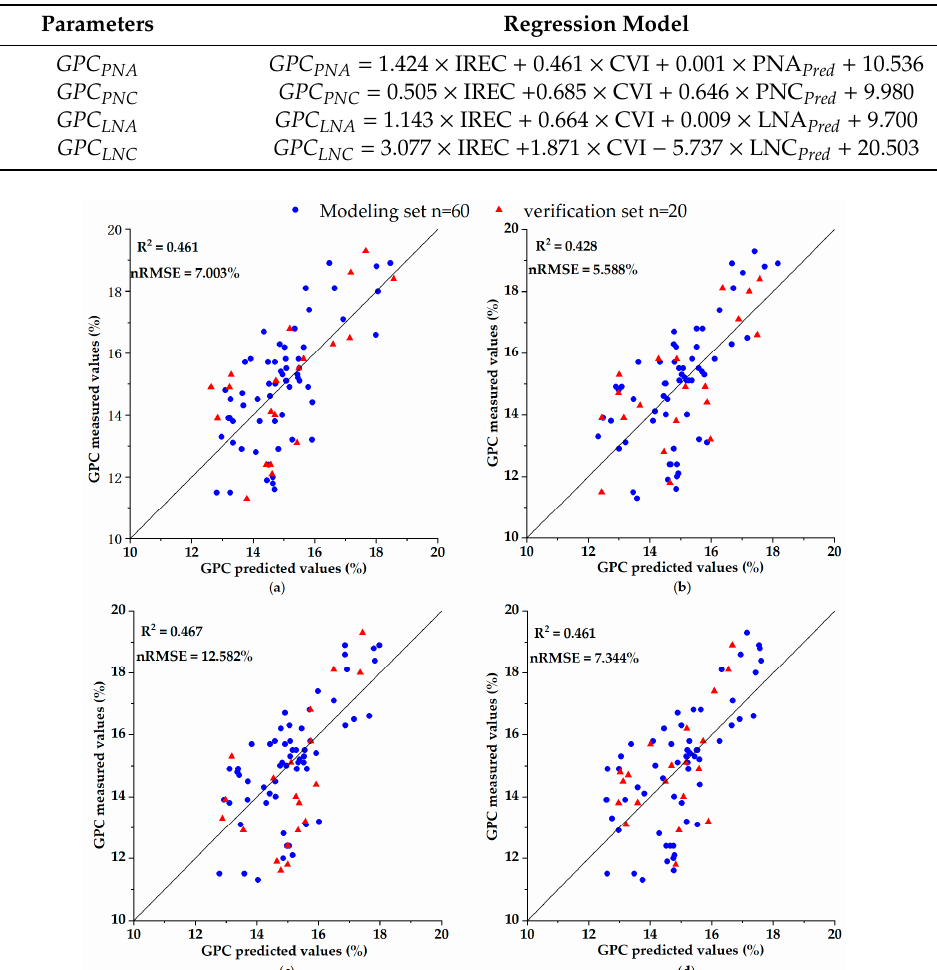
Figure 8. Relationship between measured and predicted grain protein content. ( a ) GPC estimation results based on LNC pred and vegetation indices. ( b ) GPC estimation results based on LNA pred and vegetation indices. ( c ) GPC estimation results based on PNC pred and vegetation indices. ( d ) GPC estimation results based on PNA pred and vegetation indices.